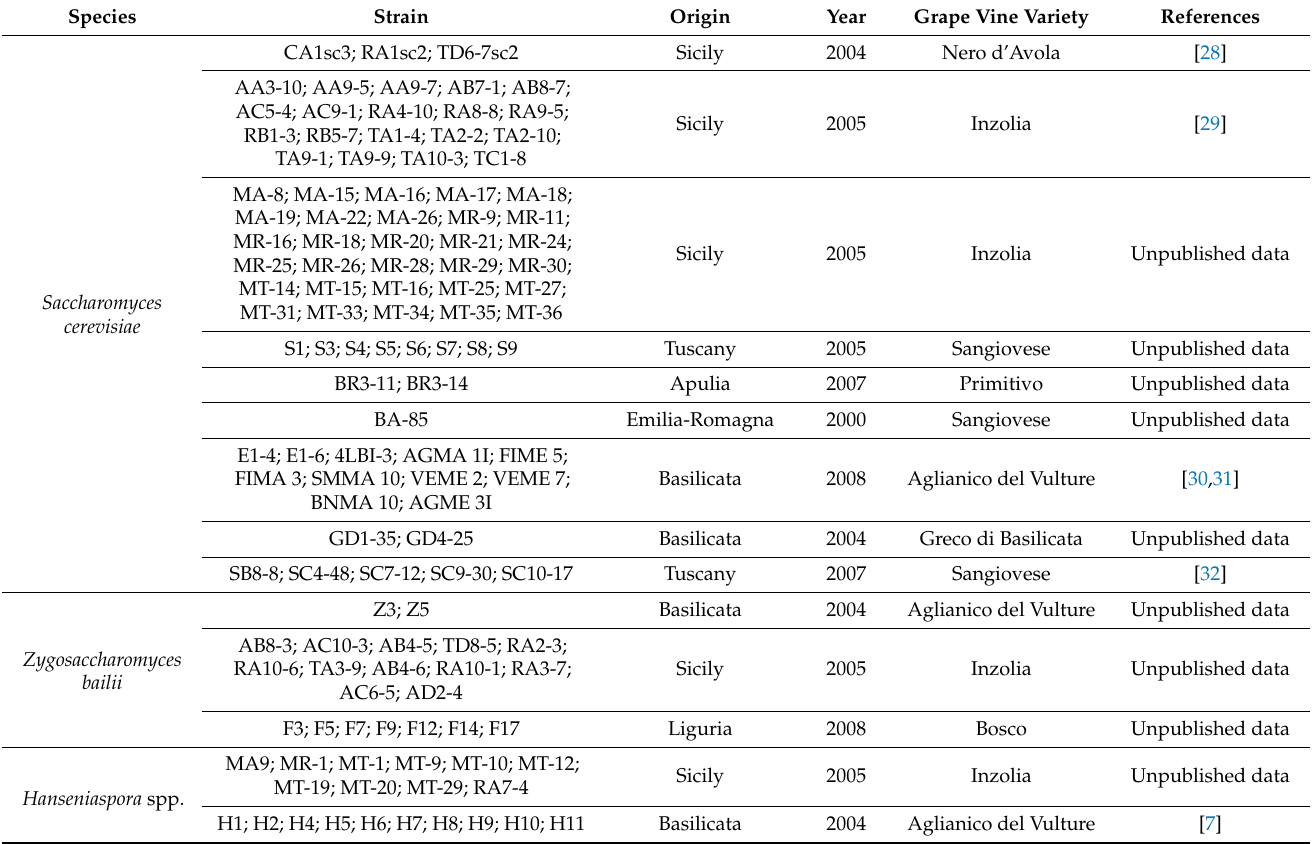
Table 1. List of the yeast strains used in this study: species and strain, origin, isolation year, grape variety, and